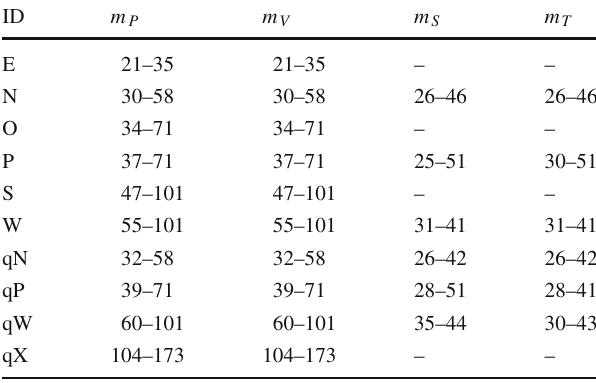
Table 3 The meson masses are determined from effective masses in the region t low < x 0 + a / 2 < t high . The table shows t low / a − t high / a for the different ensembles and channels